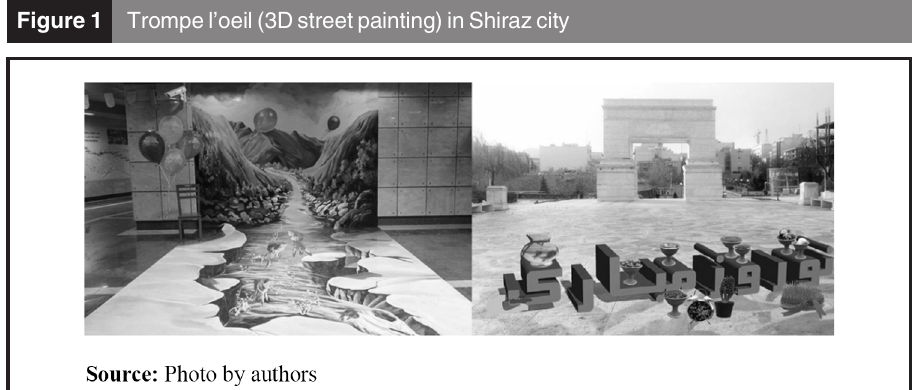
Figure 1 Trompe l ’ oeil (3D street painting) in Shiraz